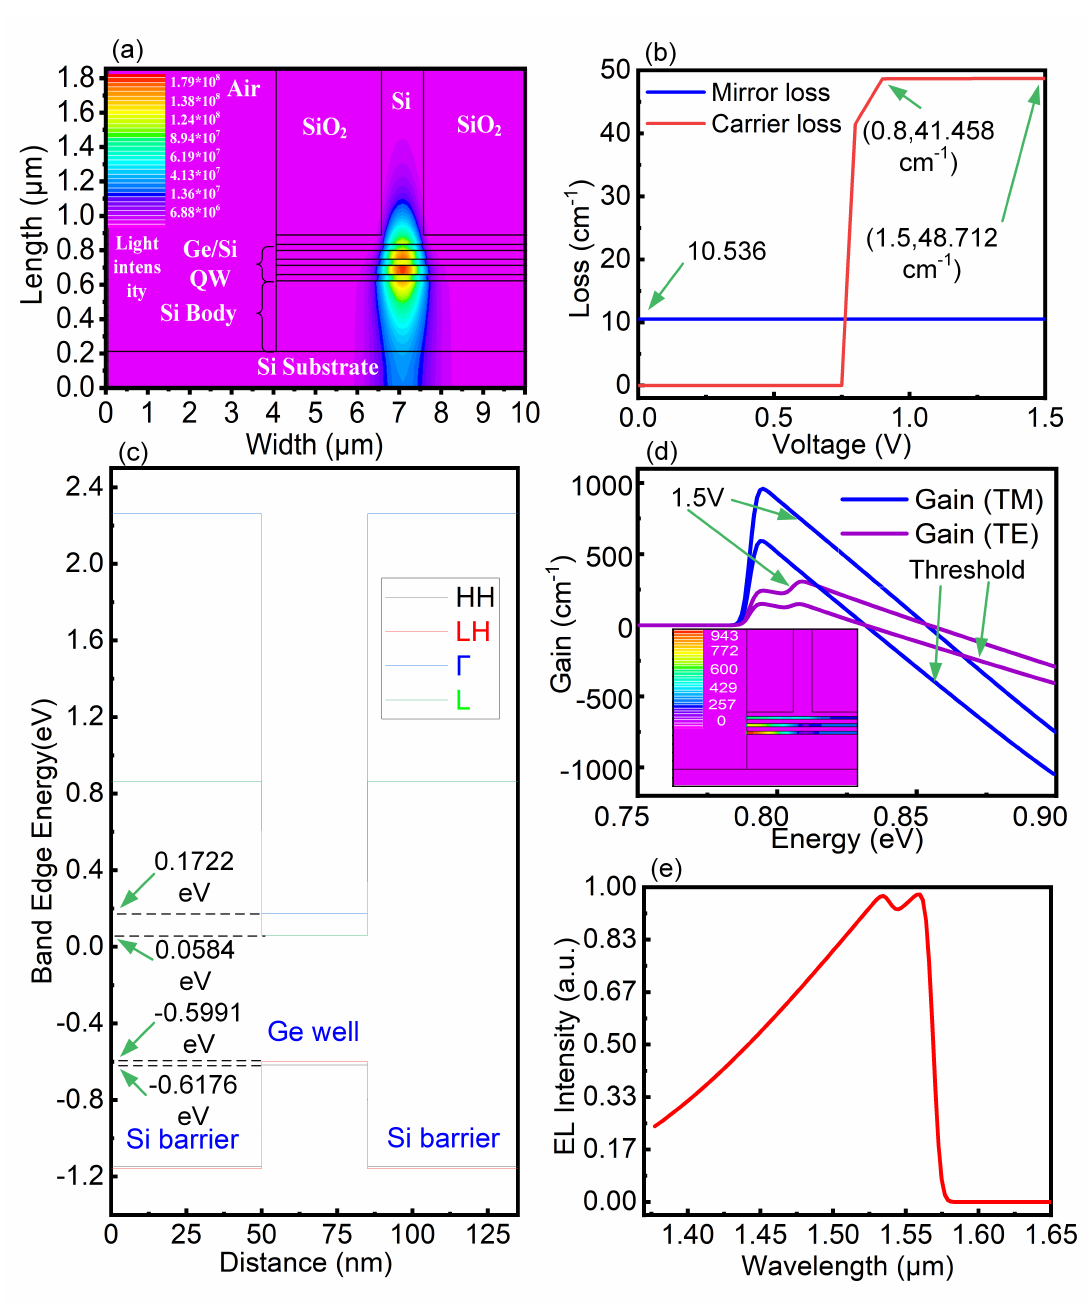
Figure 3. ( a ) Laser-light emitting field diagram. ( b ) The loss diagram of the laser. ( c ) The band edge energy diagram of the designed Ge/Si QWs under a strain of 0.2%. ( d ) Laser gain diagram at threshold and 1.5 V voltage. ( e ) The EL intensity spectrum of the